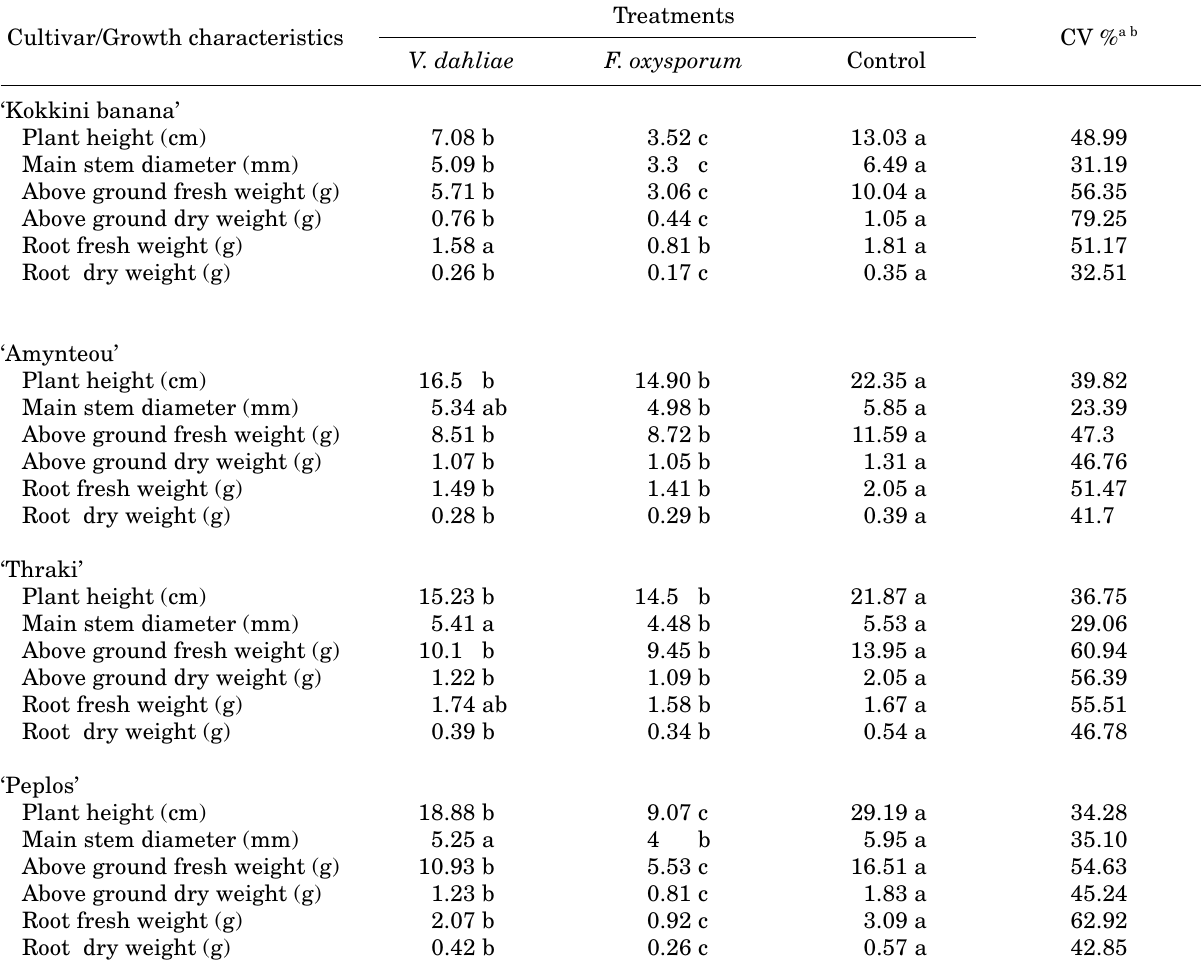
Table 3. Effect of Verticillium dahliae and Fusarium oxysporum f. sp. melonis on mean plant height, main stem diameter, above-ground fresh and dry weight and root fresh and dry weight of four melon cultivars in 1998 and